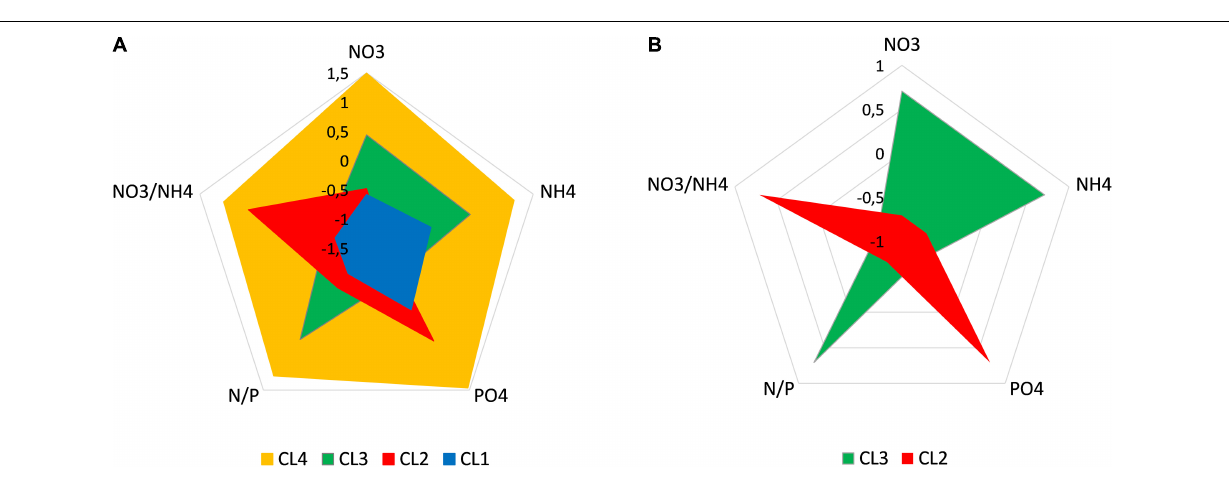
Frontiers in Marine Science |